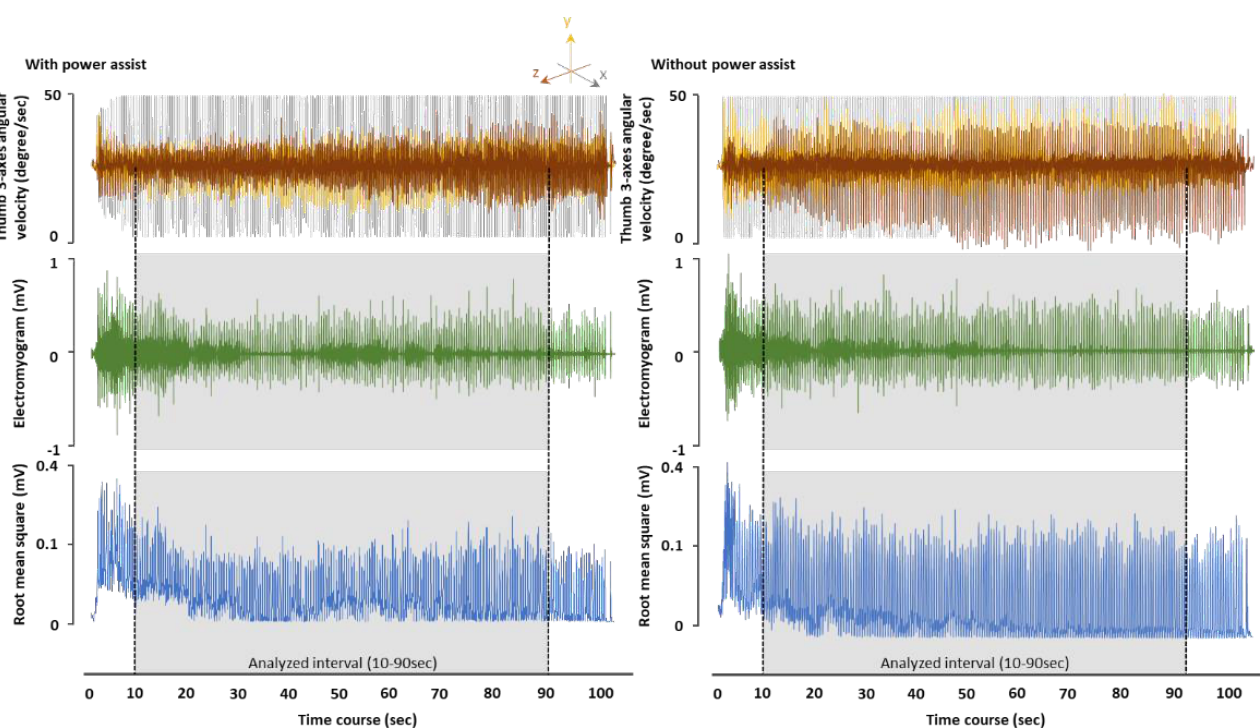
Figure 1. Thumb angular velocity (3 axes) during scissors opening and closing. The raw−surface electromyogram (sEMG) and root mean square (RMS) envelope derived from the adductor pollicis muscle (ADP) are shown in a single sample. Left panel, when power assistance is applied; right panel, no power assistance. The thumb 3−axes angular velocity is shown: gray line, x−axis; yellow, y−axis; brown, z−axis. Data was acquired for 100 s, of which 10–90 s were analyzed.